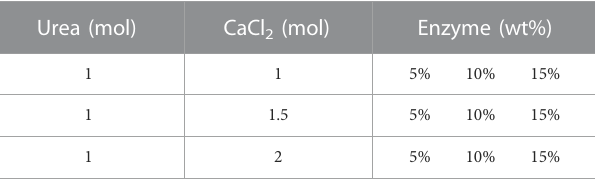
TABLE 1 The chemical formulation used for the enzyme concentration sensitivity in presence of CaCl 2